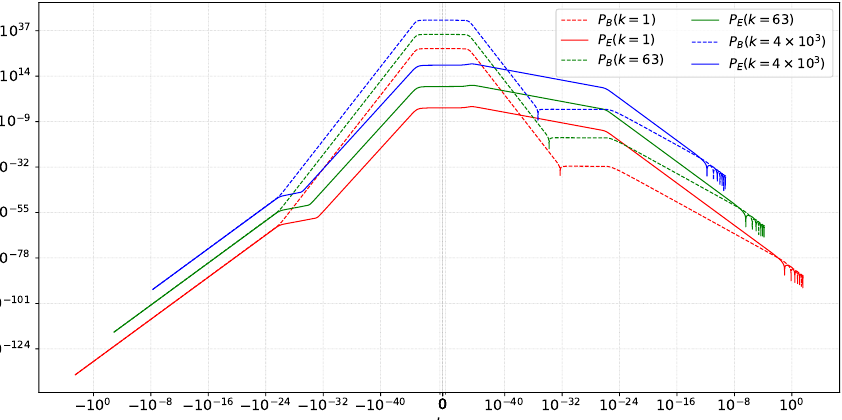
Figure 11. Evolution of the magnetic (dashed lines) and electric (continuous line) power spectra for C = 10 19 and x b = 10 30 .